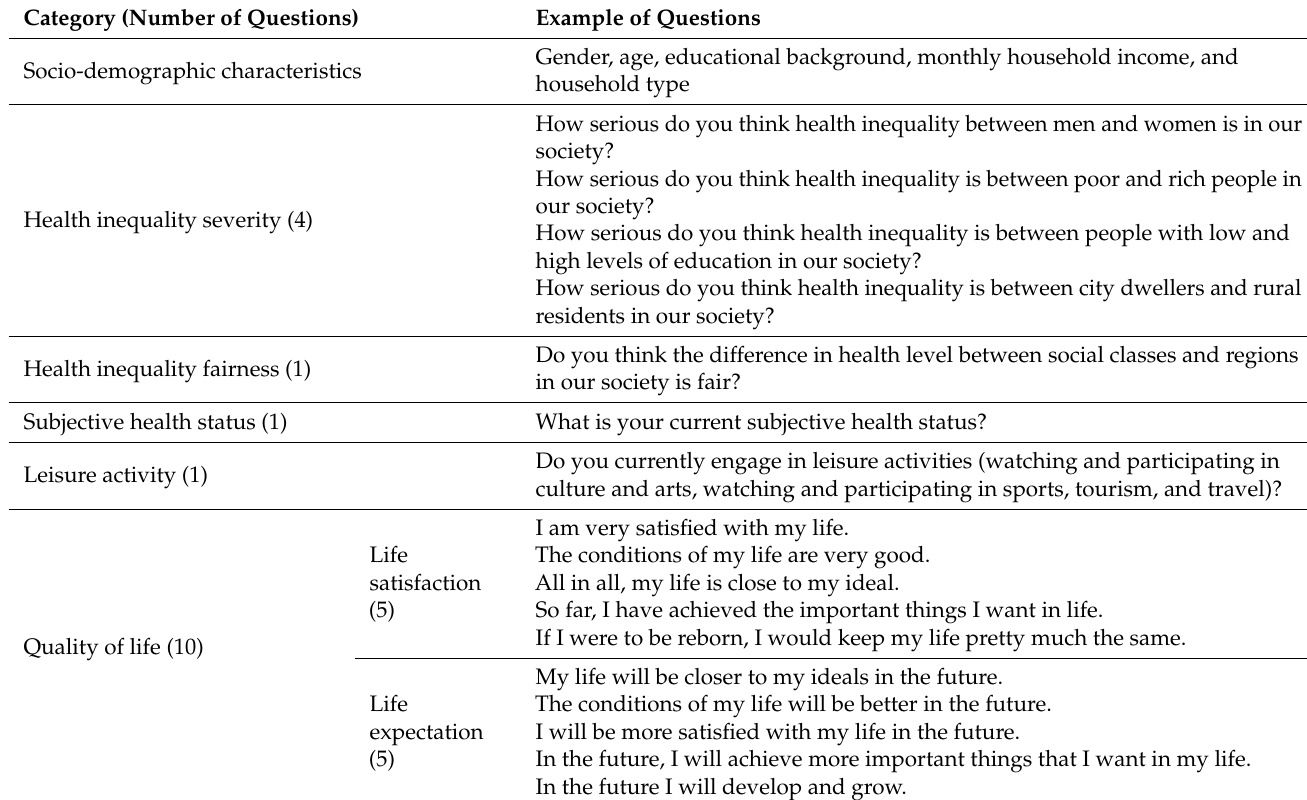
Table 2. Survey item